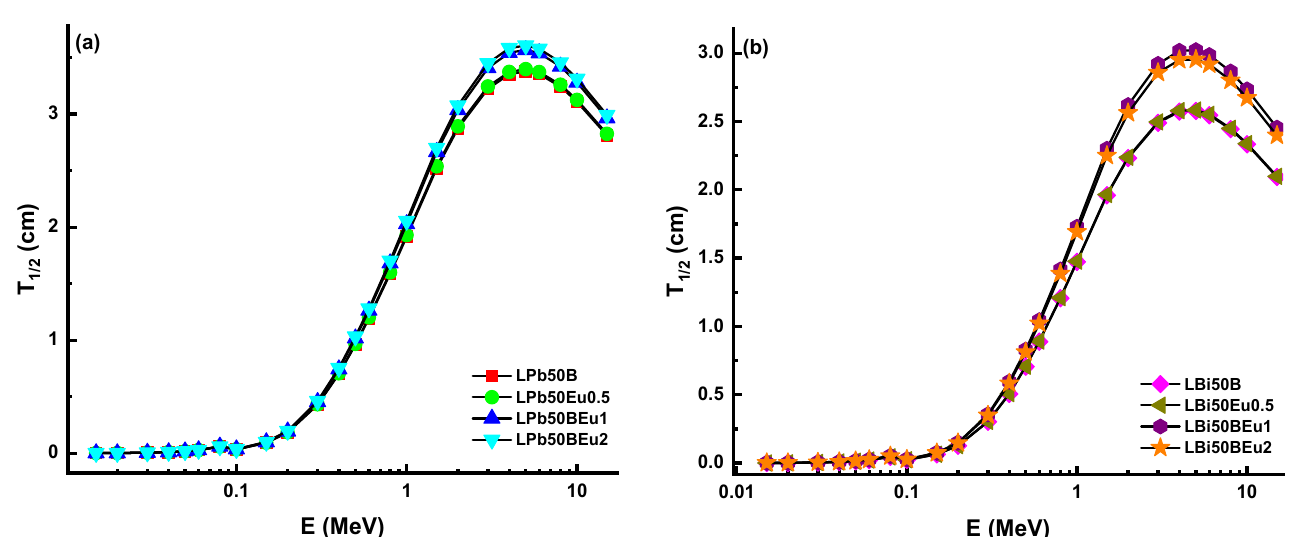
Figure 4. Variation of half-value layer (T 1/2 ) against photon energy for ( a ) LPb50BEu and ( b ) LBi50BEu glasses.